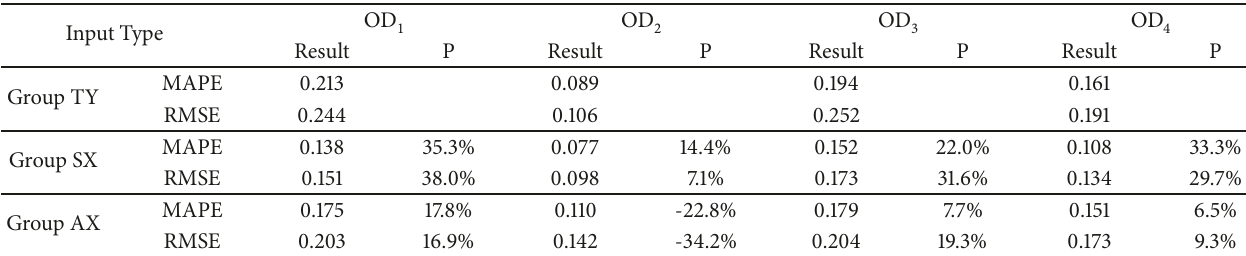
Table 4: Prediction result using MLR model for different input